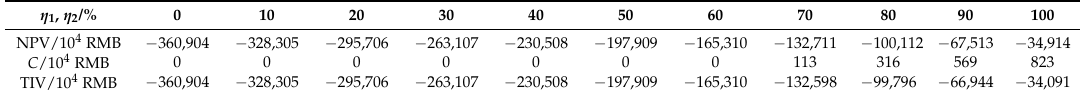
Table 8. Investment values under different government